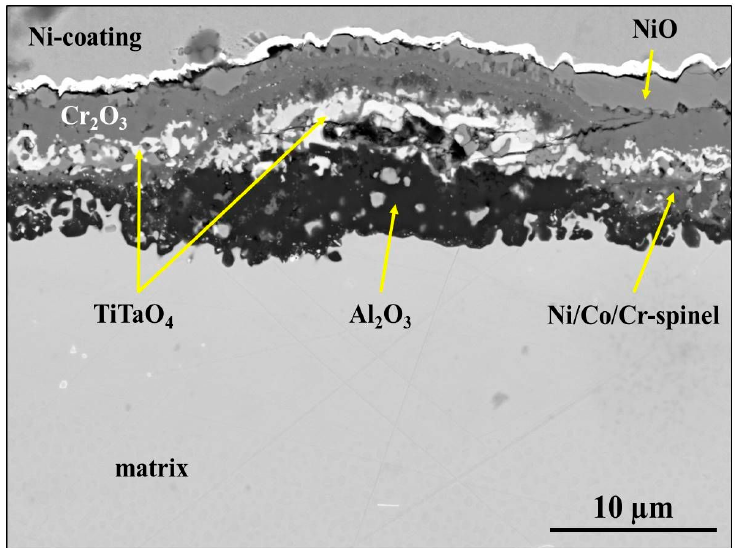
Figure 10. SEM/BSE image of the cross-section of CM247 after air oxidation at 1050 °C for 20 h.